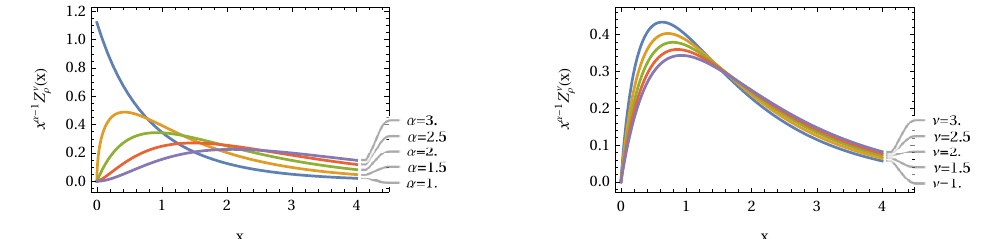
Figure 6. Error decay (cid:101) N = (cid:107) u − u ex (cid:107) ∼ K 2 N 1/2 exp ρ = ν = 3, α = 2. The least square fit delivered the values ( K 2 , k 2 ) = ( 5.713,2.807 ) .